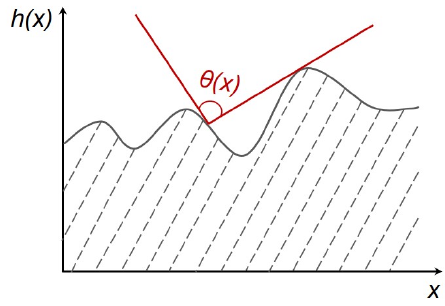
Figure 6. Shadow e ff ect diagram. Figure 6. Shadow effect diagram.